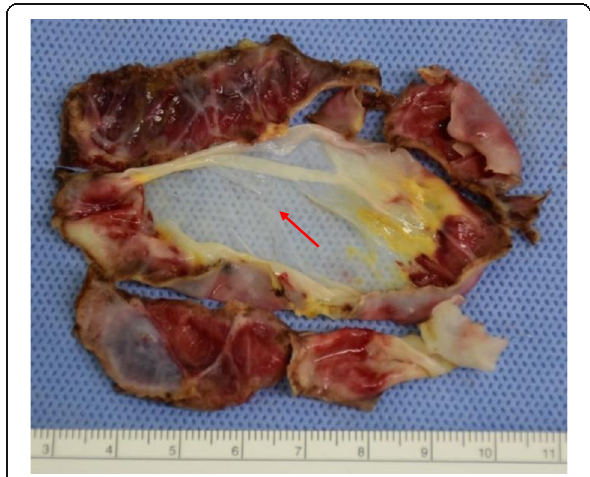
Fig. 4 The resected specimen was 7 × 8 cm in diameter, and the ruptured part was a thin wall (red